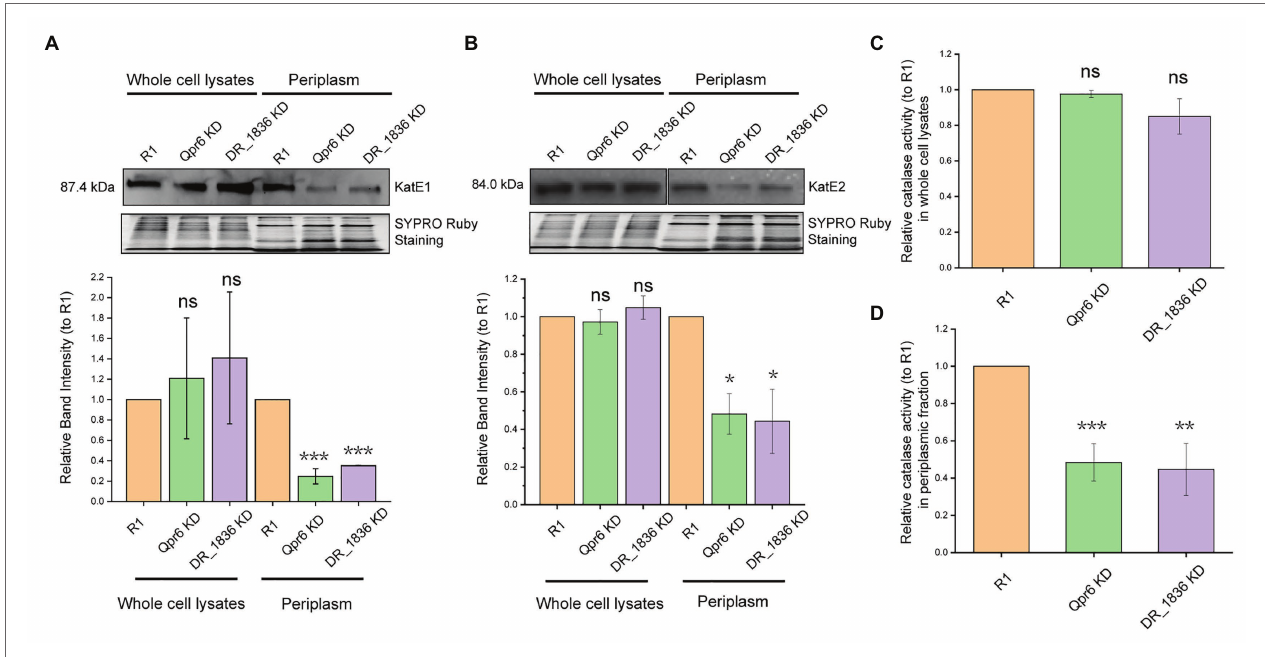
FIGURE 6 | Qpr6 affects the transport of catalases to the periplasm of D. radiodurans . (A,B) protein abundance of KatE1 (A) , and KatE2 (B) in the whole cell lysates and periplasm of R1, Qpr6 KD and DR_1836 KD. Molecular weight is indicated in kDa on the left. SYPRO Ruby staining served as a loading control to indicate that the protein amount loaded in each lane is equivalent. The signal intensity from the bands was quantified by densitometry using TotalLab CLIQS. Error bars indicate standard errors of the mean ( n = 2). (C,D) Catalase activities of the whole cell lysates (C) and the periplasmic fraction (D) in R1, Qpr6 KD, and DR_1836 KD. Error bars indicate standard errors of the means ( n = 3). * p ≤ 0.05, ** p ≤ 0.01, and *** p ≤ 0.001 were considered as significant using the Student t -test while ns indicates non-significant compared to R1 ( p >